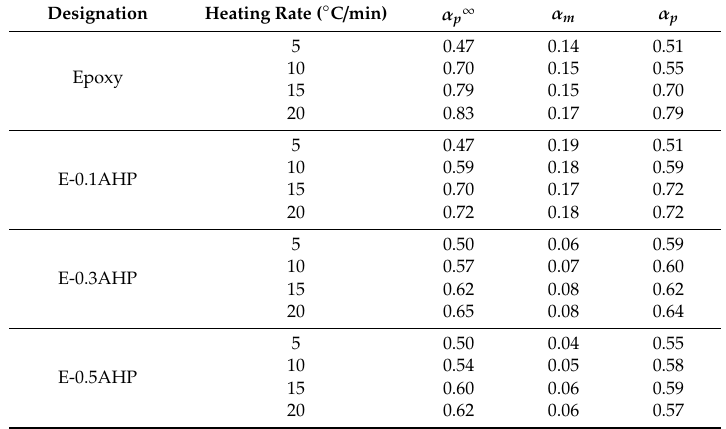
Table 2. The values of α p , α m and α p ∞ obtained from DSC analysis based on the Malek model at various heating rates.